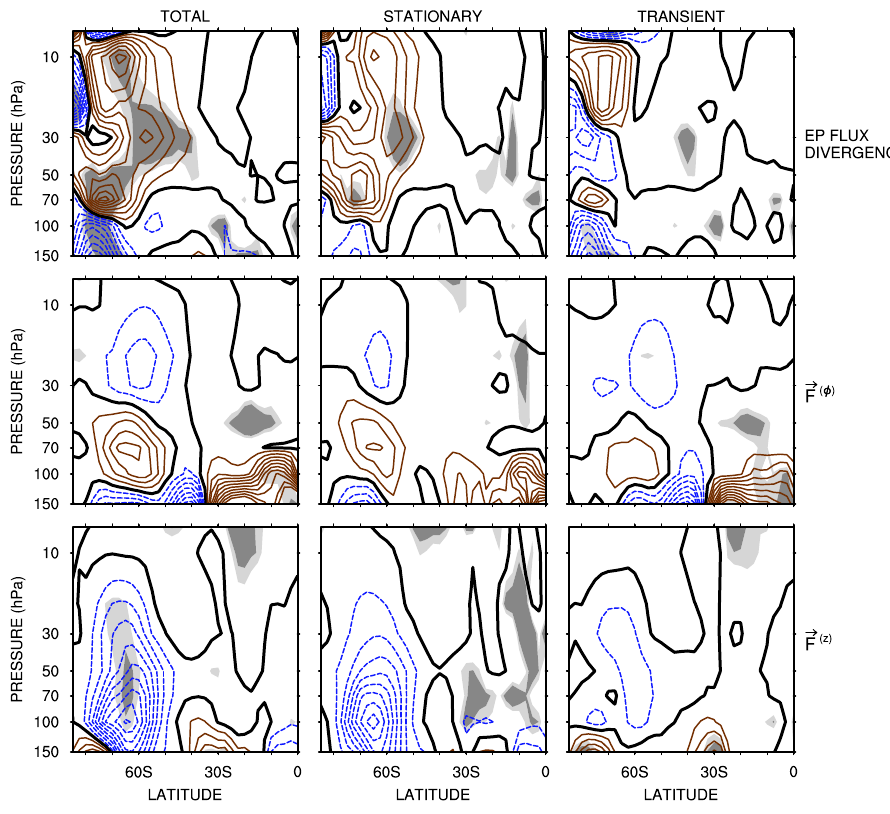
Fig. 10. Trends in the ERA-40 EP flux vector and its divergence, including stationary and transient components, for the month of November in the SH. Dashed blue (solid brown) lines represent negative (positive) trends while the bold solid line represent the zero-line. Light grey (dark grey) shadings represent the 90% (95%) statistical significance level of the trends. Contour interval is 0.2ms − 1 day − 1 per decade for the EP flux divergence, 2 × 10 5 kgs − 2 per decade for F (φ) and 2 × 10 3 kgs − 2 per decade for F (z) .